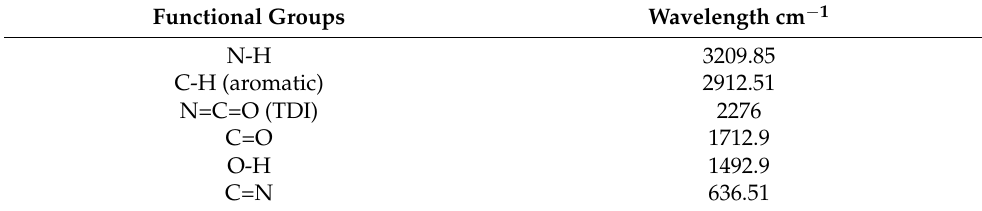
Table 5. Wave number for functional groups of turmeric essential oil.